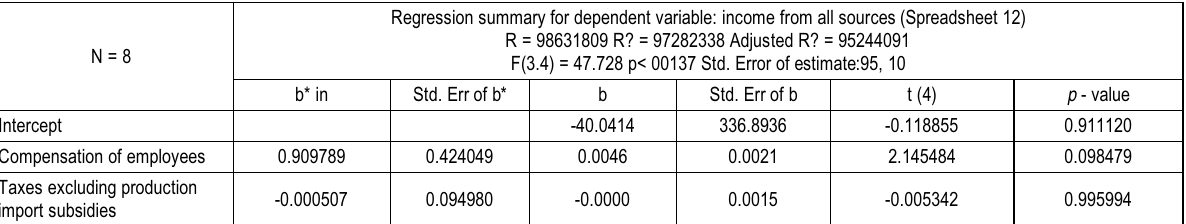
Table 5.The results of correlation and regression analysis in the Statistica